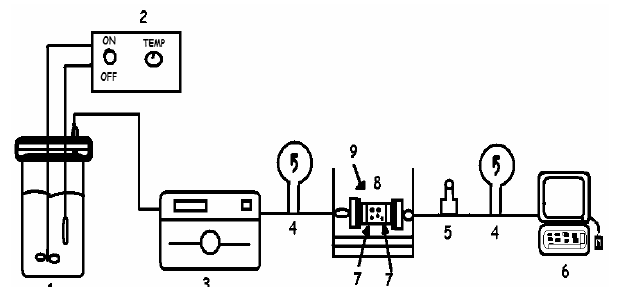
Figure 3. Experimental set-up used to determine the adsorption capacity of the molecular sieves.